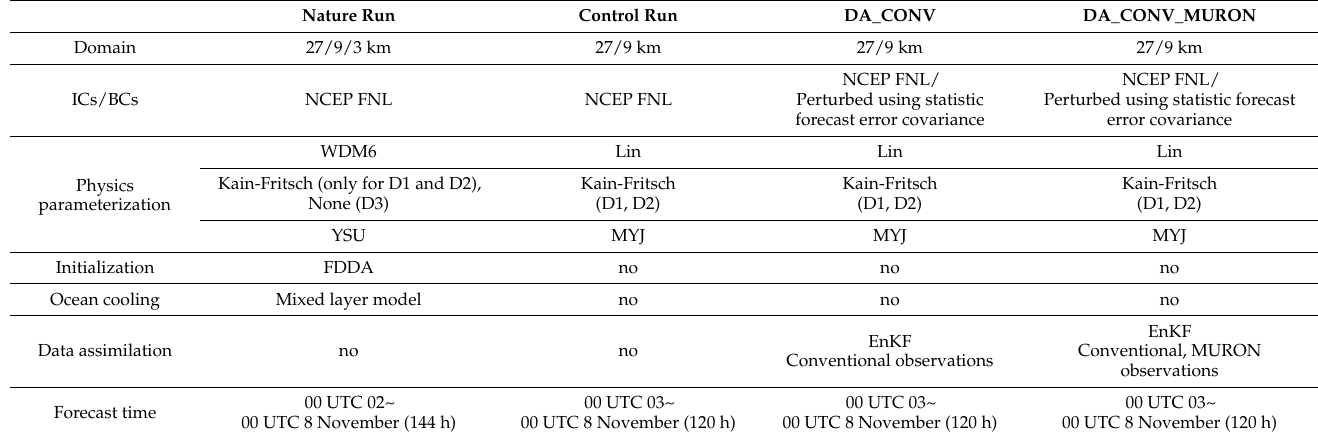
Table 2. Experimental configuration for nature run, control run, and DA